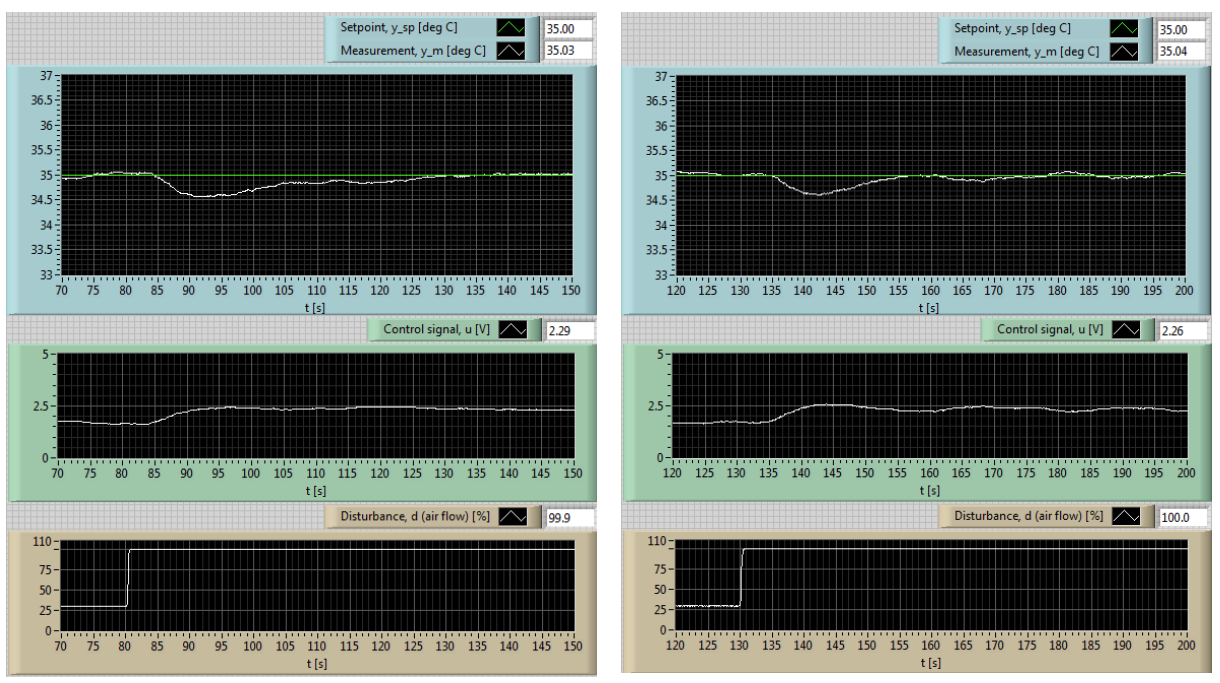
Figure 9: Temperature control system: Disturbance Figure 10: Temperature control system: Disturbance step responses with Ziegler-Nichols